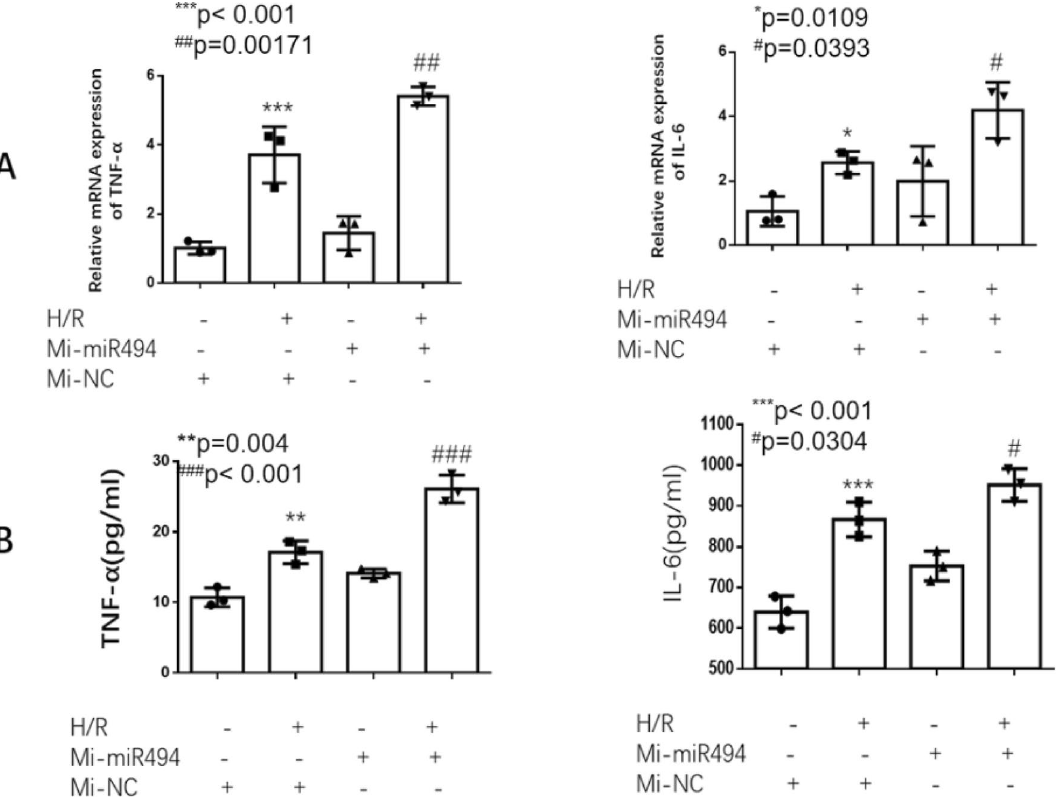
Figure 4. Hsa-miR-494-3p mimics increased ischemia/reperfusion-induced inflammatory response in HK2 cells. ( A ) Real-time PCR data show hsa-miR-494-3p mimics further increased ischemia/reperfusion-induced mRNA of TNF-α and IL-6; ( B ) ELISA data show overexpression of hsa-miR-494-3p significantly increased ischemia/reperfusion-induced TNF-α and IL-6. N (the replicate for above experiments) = 3. *P < 0.05, **P < 0.01, ***P < 0.001, versus control. # P < 0.05, ## P < 0.01, ### P < 0.001, versus hypoxia/reoxygenation treatment